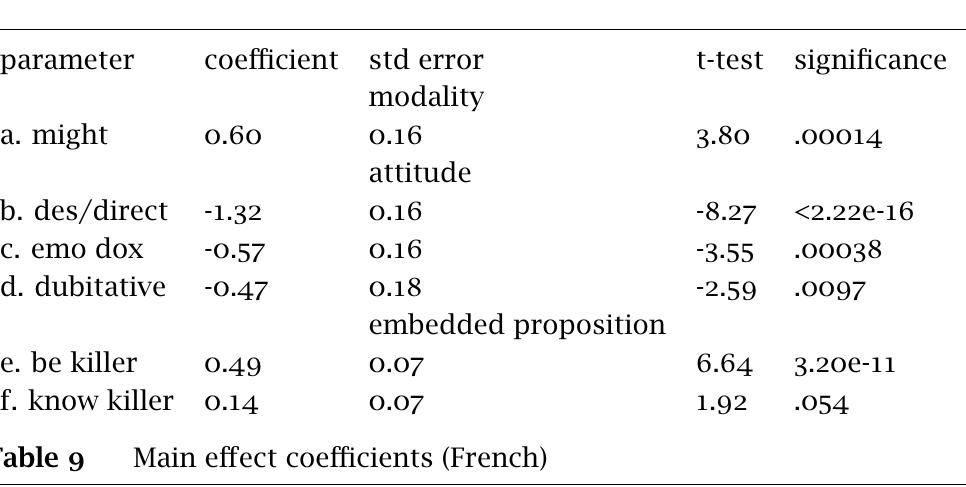
Main effect coefficients